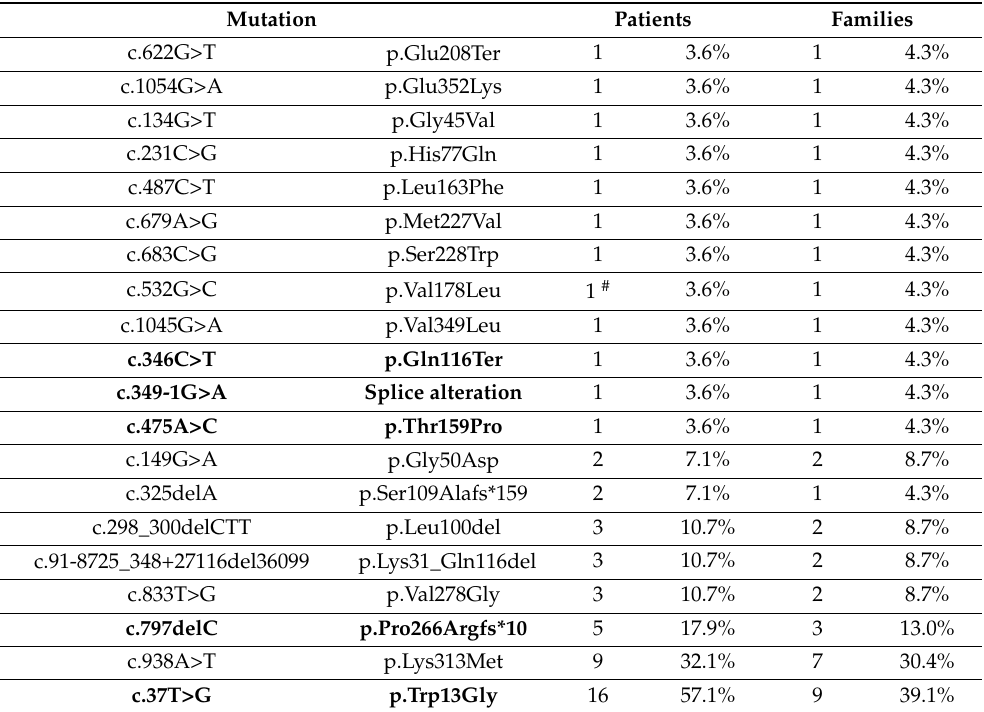
Table 2. WARS2 variants of the newly described patients and patients in the